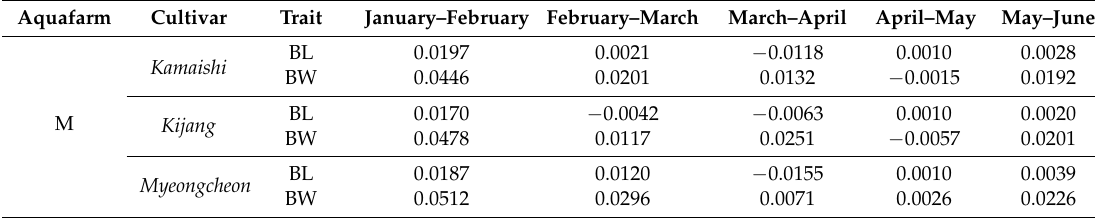
Table 3. Daily relative growth rates of blade lengths (BL) and blade weights (BW) for three cultivars of U. pinnatifida at Myeongcheon (M) and Gyedo (G) aquafarms between January and May 2003. Aquafarm Cultivar